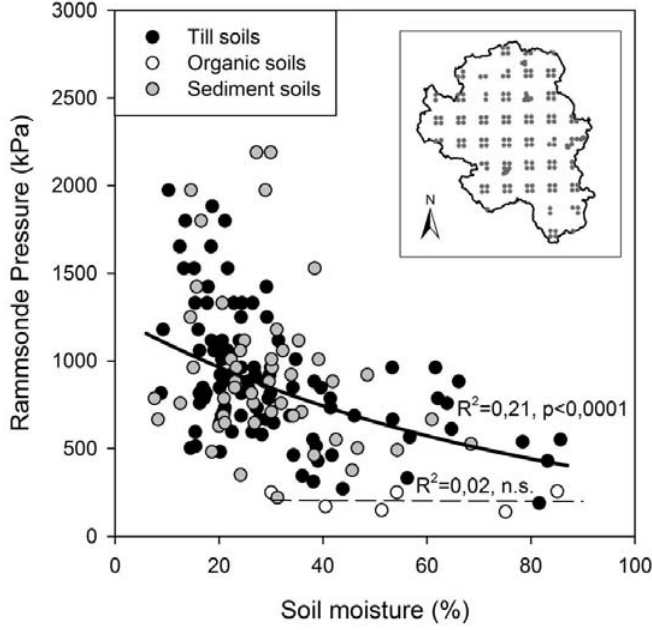
Figure 8. Rammsonde Pressure (RP) and soil moisture measured at 160 locations in the Krycklan Catchment (inset figure). Results are divided into mineral soils (grey and black dots) and organic soils (white dots). Modified from Edlund